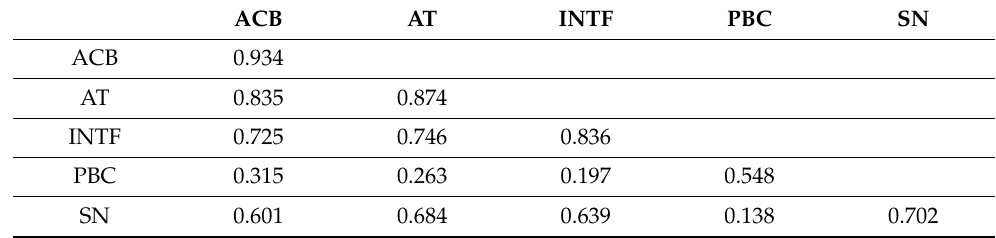
Table 7. Fornell–Larcker Criterion. Note: Value in diagonal represents the square-root of AVE.